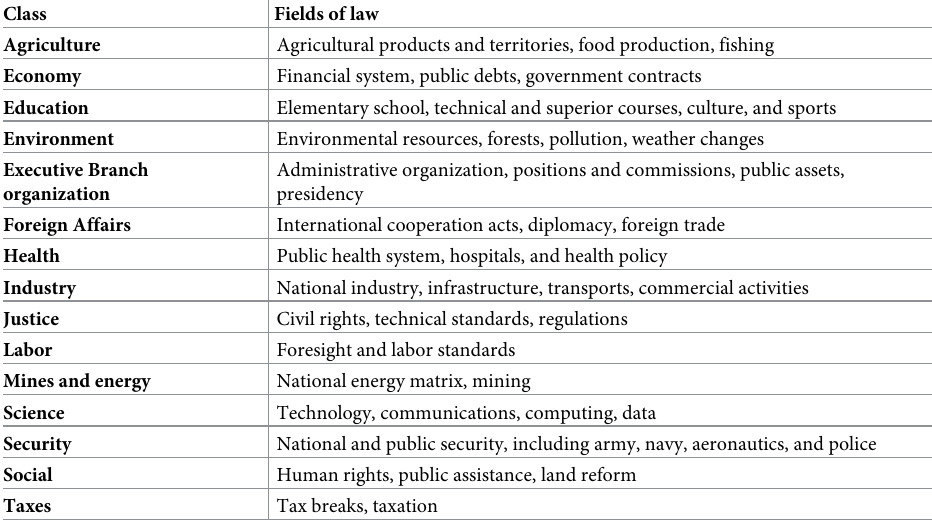
Table 5. Senate-based taxonomy